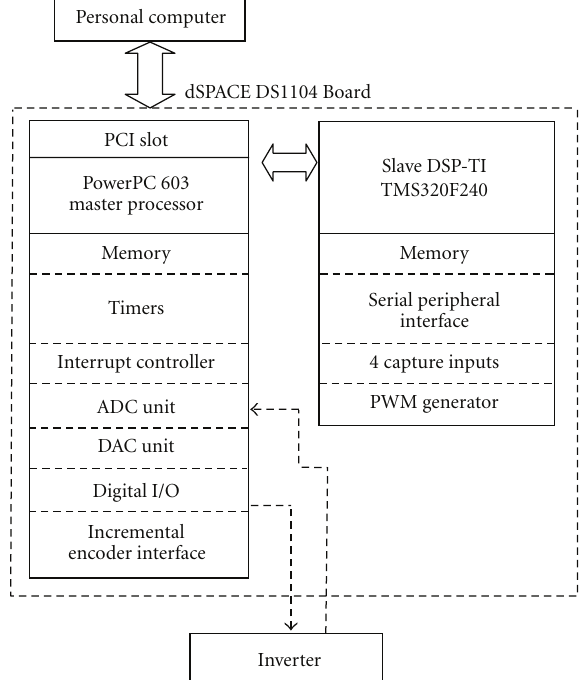
Figure 1: Block diagram of the dSPACE DS1104 controller board.